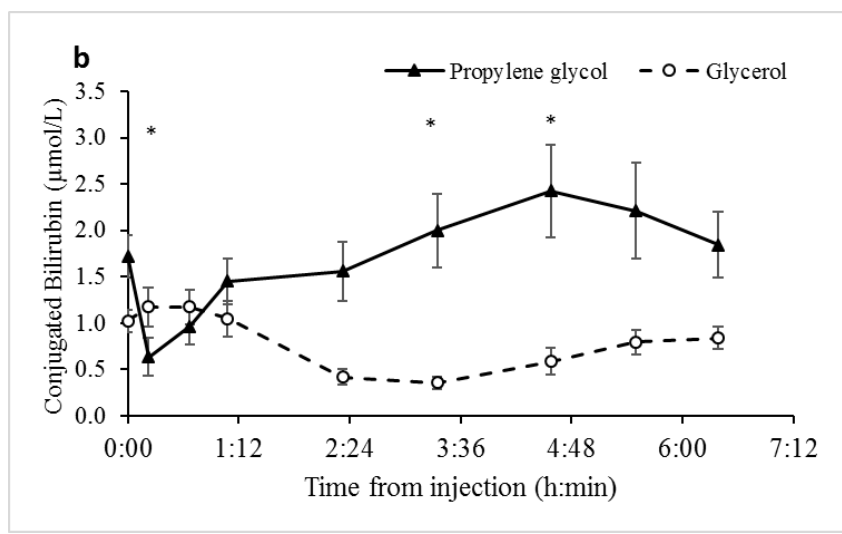
Figure 7. Concentrations of bilirubin as a function of Time from the propylene glycol and glycerol treatments. ( a ) Total bilirubin. Analysis indicates e ff ects of Treatment, Time, and Treatment × Time interaction (Table 1). SEM = 0.192. Values represent mean ± SE. ( b ) Conjugated bilirubin. Analysis indicates e ff ects of Time and Treatment × Time interaction (Table 1). SEM = 0.192. Values represent mean ± SE. * Significant di ff erence at α = 0.00625 after Bonferroni correction. The di ff erence in values for total ( a ) and conjugated ( b ) bilirubin are substantial. Specifically, unconjugated bilirubin accounts for a significant portion of the total bilirubin, which is highly indicative of increased hemoglobin catabolism and intravascular hemolytic activity [32].